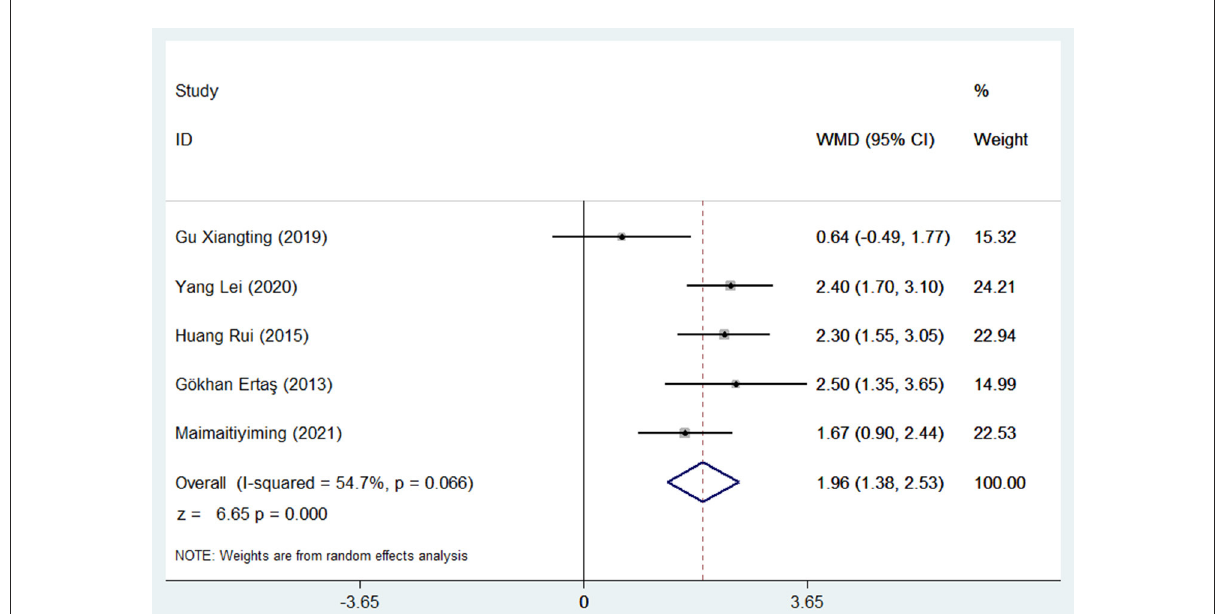
FIGURE3 Forest plot meta-analysis of associations between different stroke outcomes and NLR levels in patients with AF.